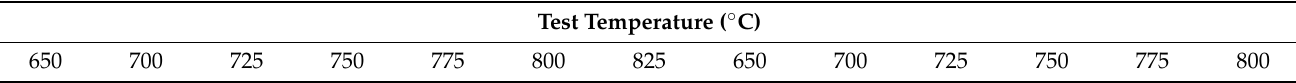
Table 2. Experimental Temperature